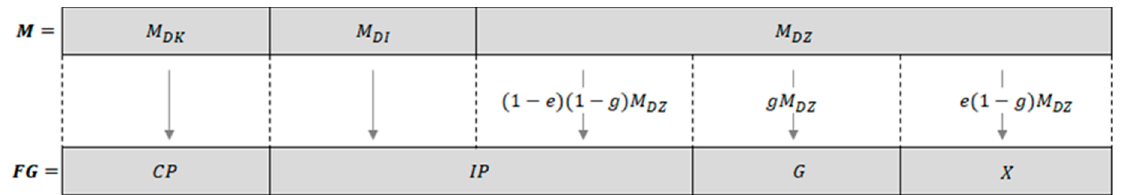
Figure 1. Decomposition of import and final production, own work.